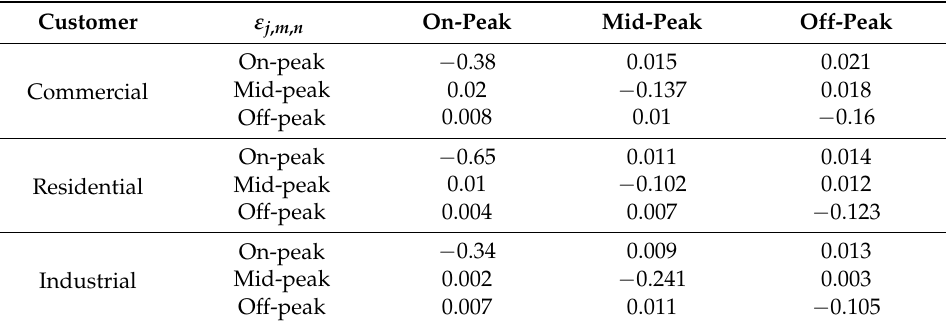
Table 3. Price elasticity coefficients of